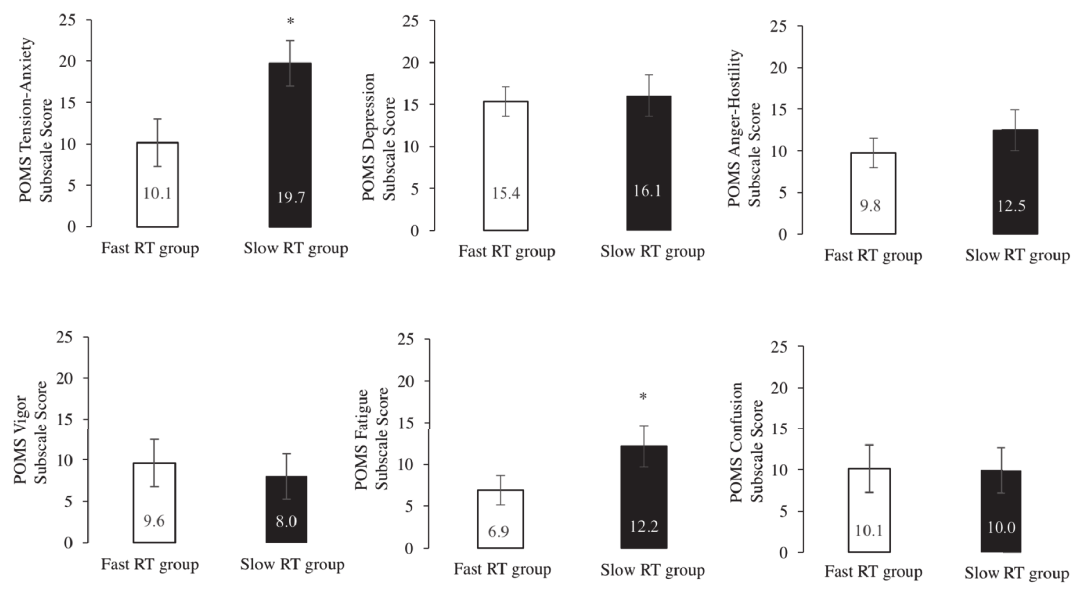
Fig 3. Comparison of negative POMS scores between subjects with fast and slow RTs. Mean RTs for the slower ( n = 8) and faster ( n = 19) groups were 778 ( SD = 33) ms and 927 ( SD = 86) ms, respectively. Both Tension-Anxiety ( t = 4.108, p < .001, r = .64) and Fatigue ( t = 2.724, p < .01, r = .48) subscale scores in subjects with slower RTs were significantly higher relative to those observed in subjects with faster RTs. Non-paired t test, (cid:3) p < .05.